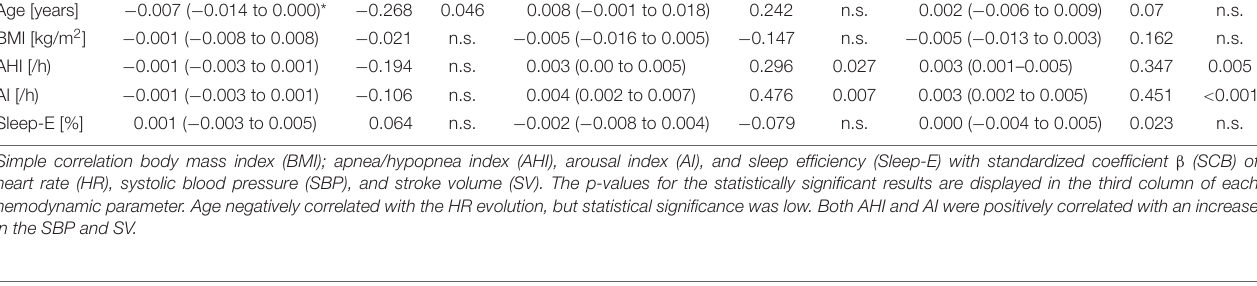
TABLE 5 | Hierarchical regression analysis of anthropometric and sleep variables for the hemodynamic standardized coefficient β prediction of heart rate. Standardized coefficient β (SCB) of Heart Rate (HR)